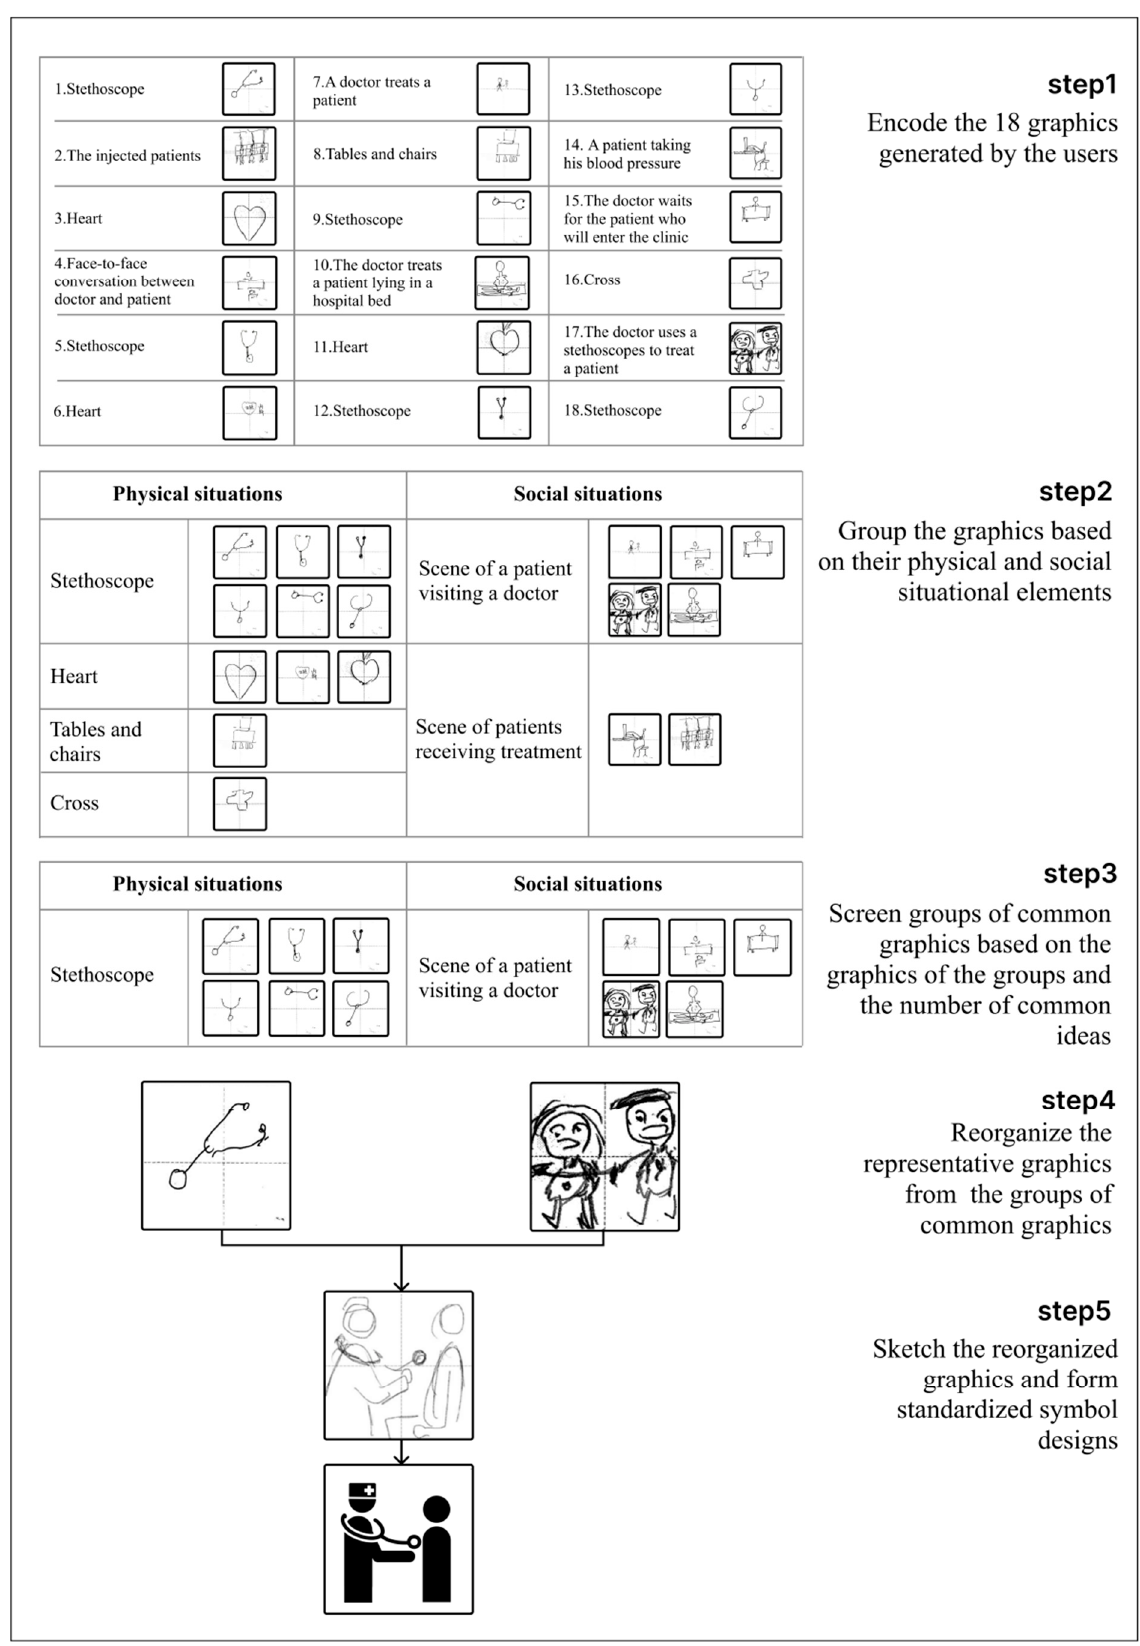
Figure 4. Extraction and prototyping of healthcare symbols for the “internal medicine department” and the development of a design.